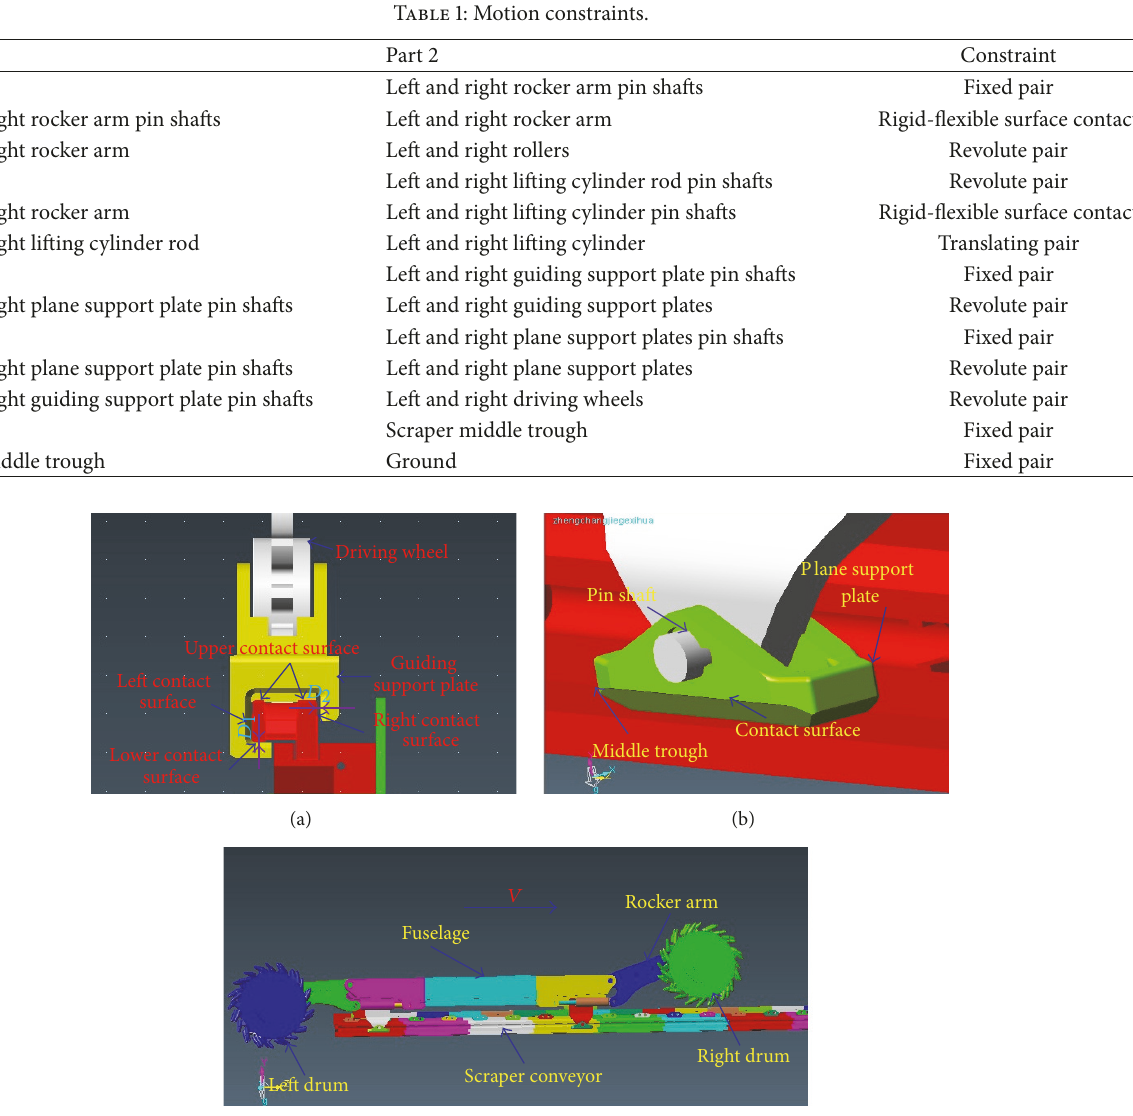
Figure 1: Definition of various contact surfaces. (a) The guiding support plate contacts the pin row. (b) The plane support plate contacts the middle trough. (c) The proposed rigid-flexible coupling